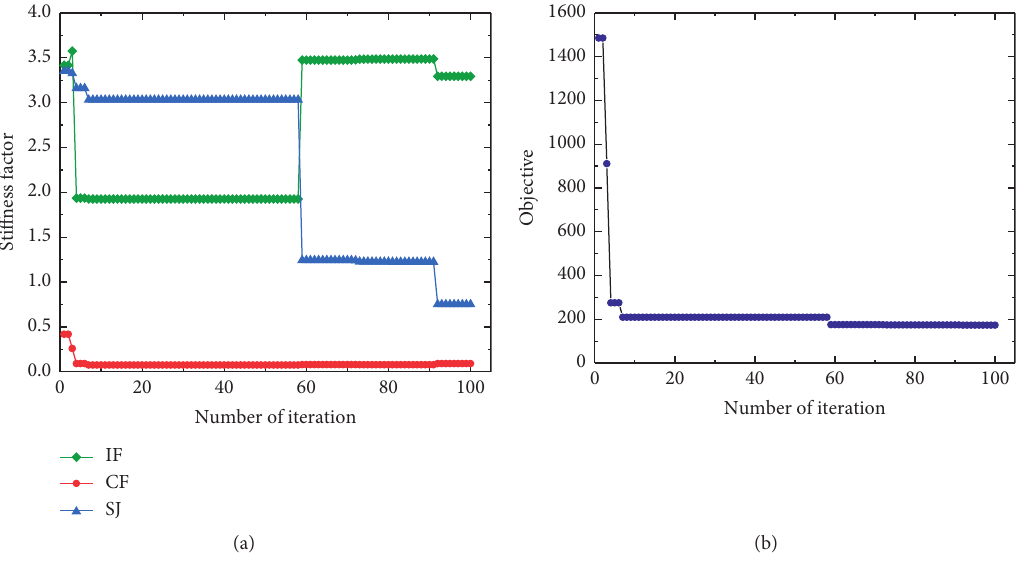
Figure 14: The results of the optimization: (a) the variation of stiffness factors, and (b) the variation of the